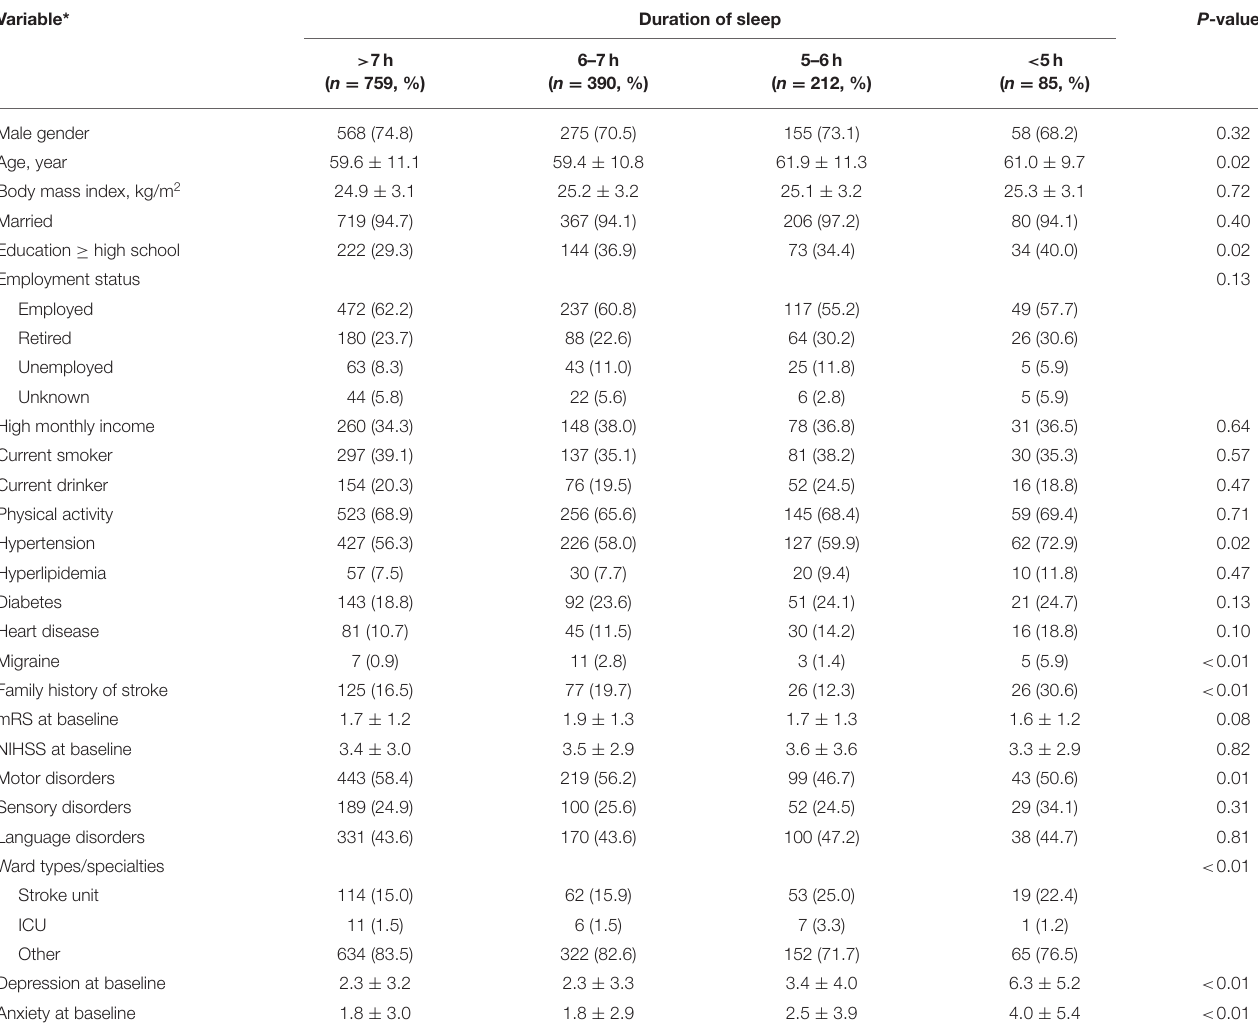
TABLE 1 | Baseline patient characteristics stratified by sleep durations. Variable*